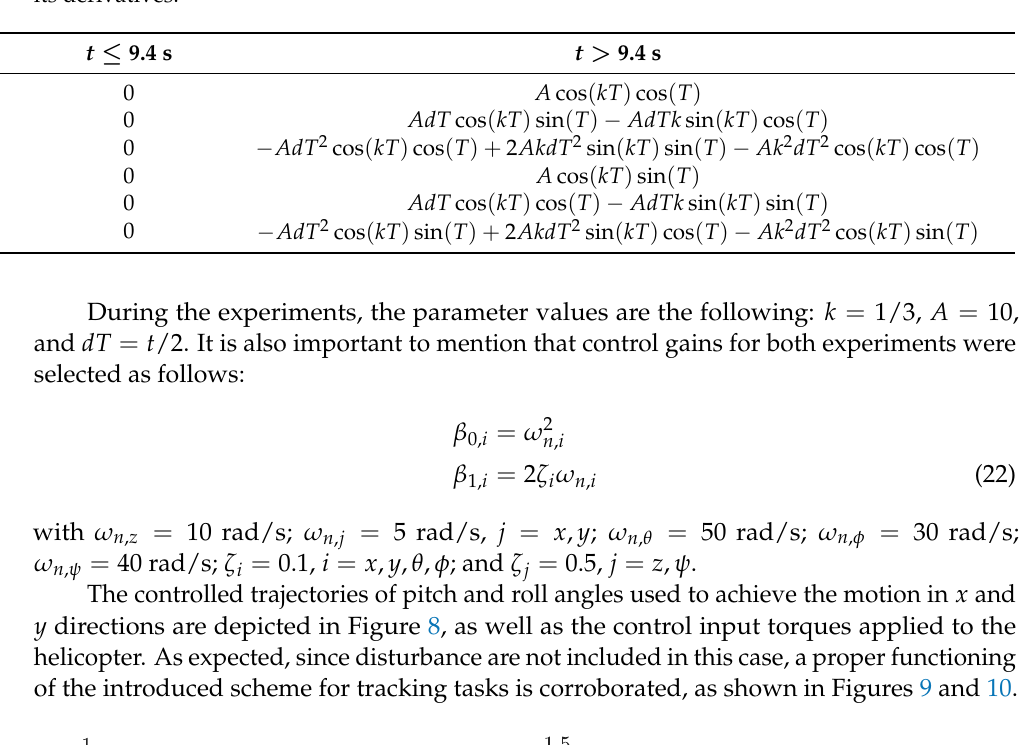
Table 2. Planned position, velocity, and acceleration references described by a Lissajous curve and its derivatives.